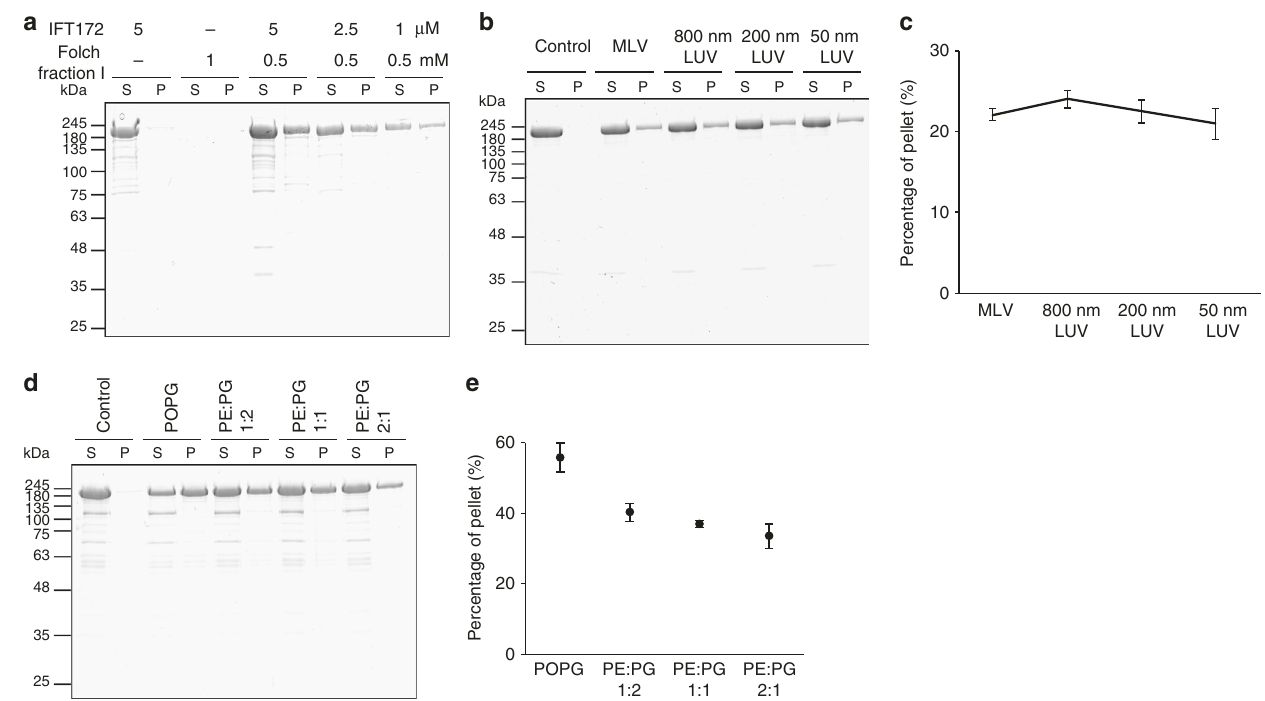
Fig. 3 Liposome sedimentation assays of Chlamydomonas IFT172. a Co-sedimentation assay of IFT172 with Folch fraction I multilamellar vesicles (MLV), showing direct binding of IFT172 to membrane. S: supernatant and P: pellet. b , c Co-sedimentation assay of IFT172 with Folch fraction I MLV and large unilamellar vesicles (LUVs) of different sizes ( b ) and their quanti fi cation ( c ). Error bars in ( c ) depict standard deviations from three separate experiments. IFT172 has no preference for different membrane curvatures. d , e Co-sedimentation assay of IFT172 with liposomes containing different ratios of POPE and POPG (D) and their quanti fi cations ( e ). Error bars in e depict standard deviations from three separate experiments. IFT172 has a preference for negatively charge lipids. The experiments were performed three independent